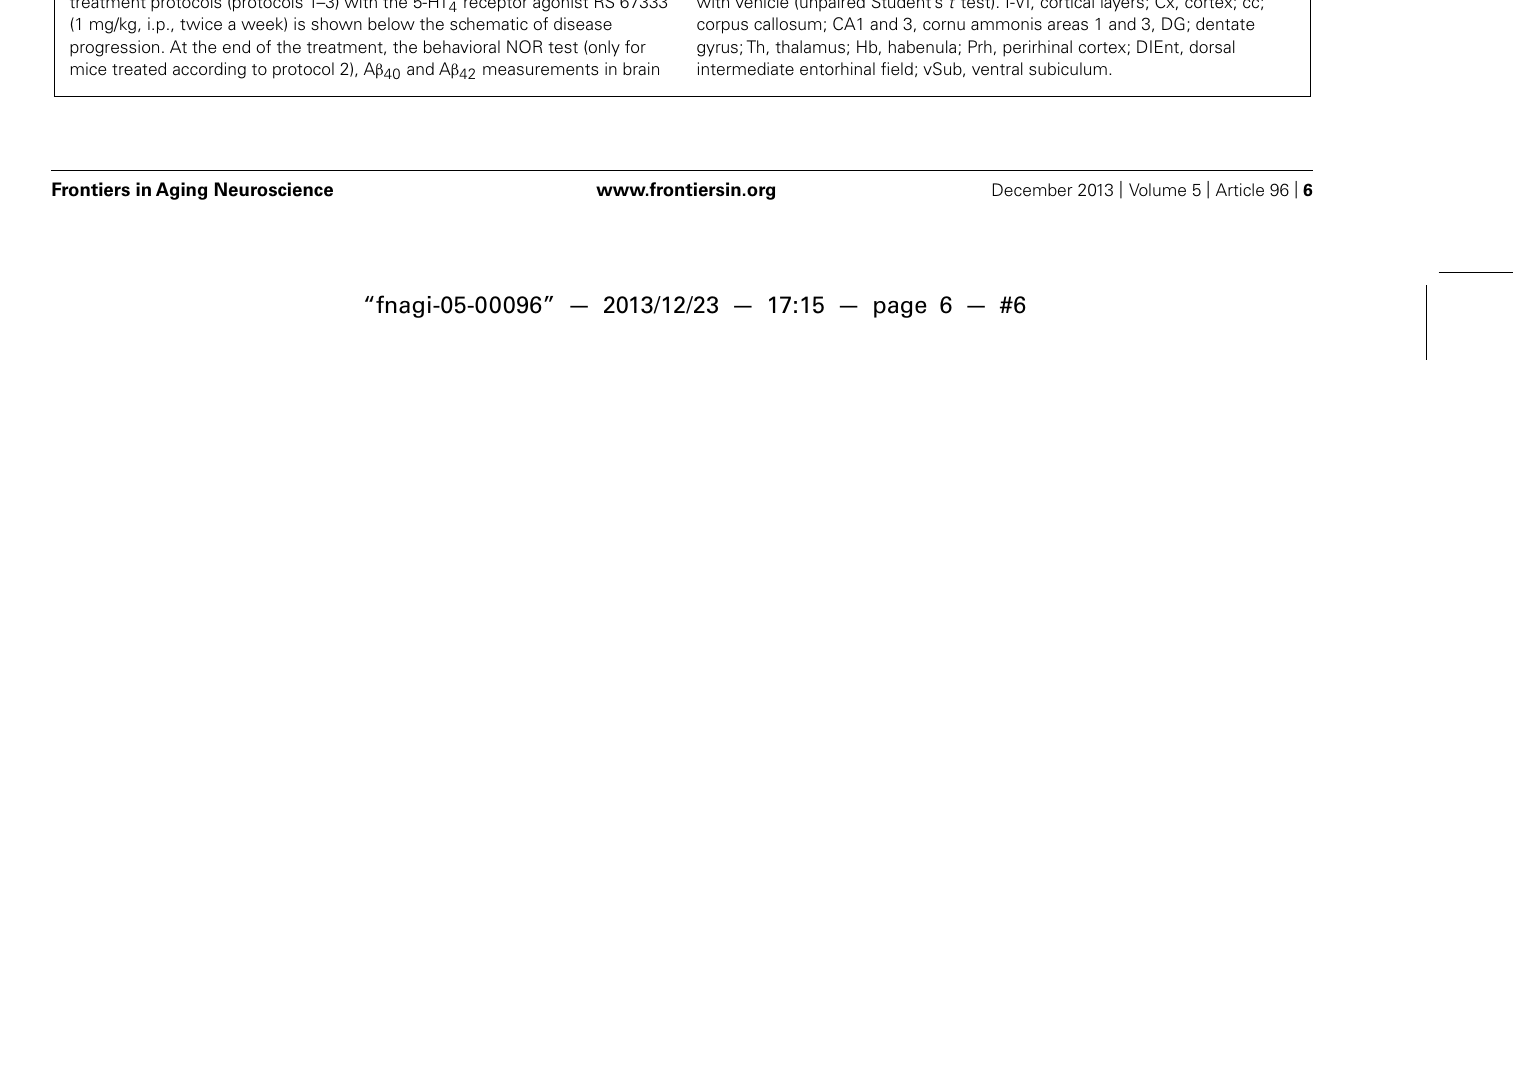
extracts, quantification of amyloid plaques and glial reactivity in brain slices were performed. (B) Representative images of thioflavinT staining of amyloid plaques in the frontal cortex (a,d), hippocampus (b,e), and entorhinal cortex (c,f) (B) from 5XFAD mice treated with RS 67333 (protocol 1) or vehicle alone. Images are mosaics collected with an AxioImager Z1 microscope, 10X objective (b–d). Quantification of A β load (number of plaques/mm 2 ) in